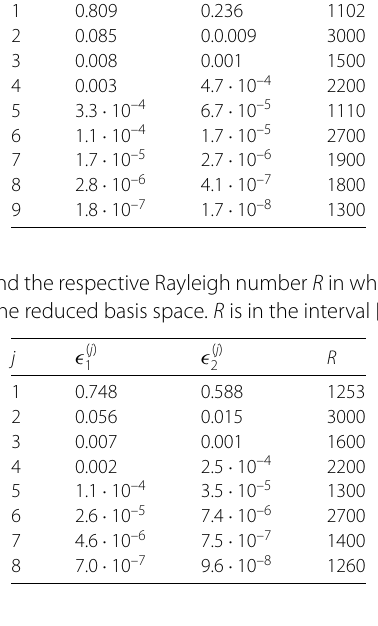
Table 4 (cid:15) ( j ) , (cid:15) ( j ) , j = 1, ... , N and the respective Rayleigh number R in which the maximum takes 1 2 place for different dimensions j of the reduced basis space. R is in the interval [1253;1538] for solutions S 3 in the upper part of the table and R is in the interval [1538;3000] for solutions S 3 in the lower part of the table